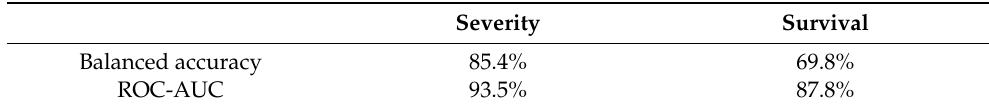
Table 2. Evaluation metrics for COVID-19 severity and survival models without comorbidities in the training